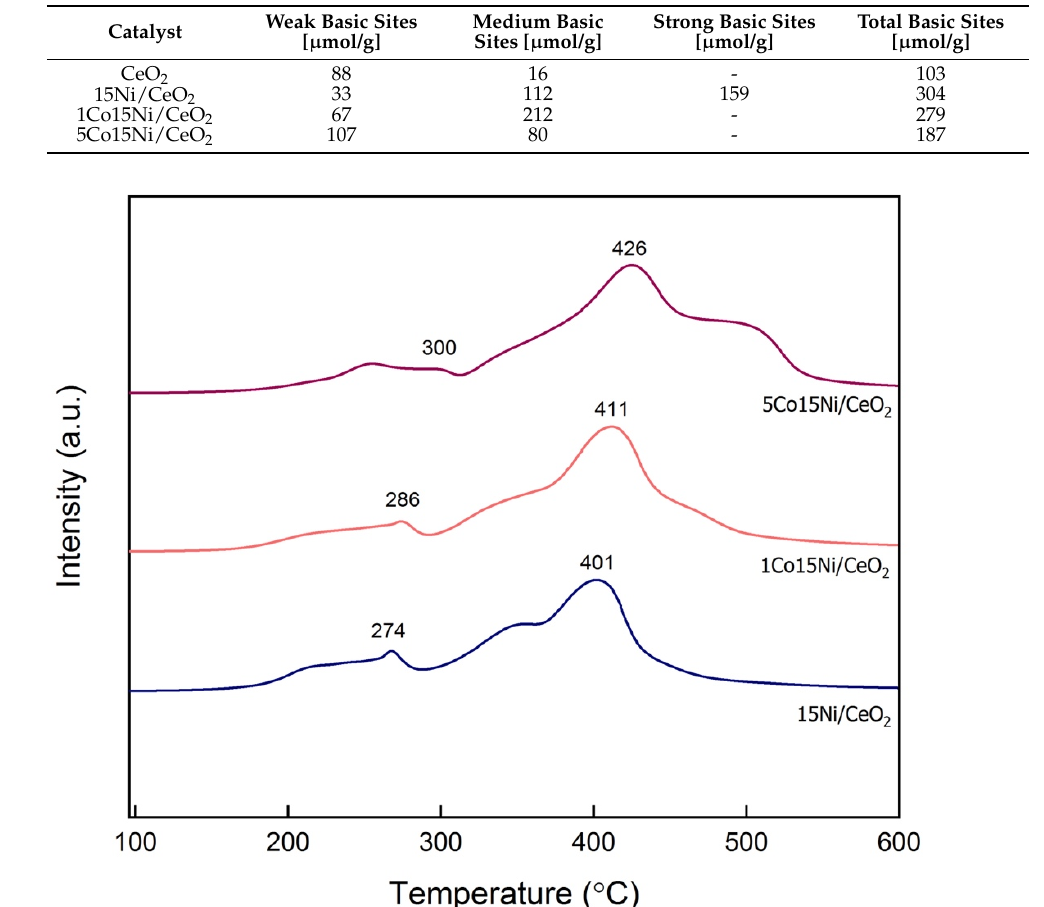
Table 2. Comparison of basicity of the samples in present study.